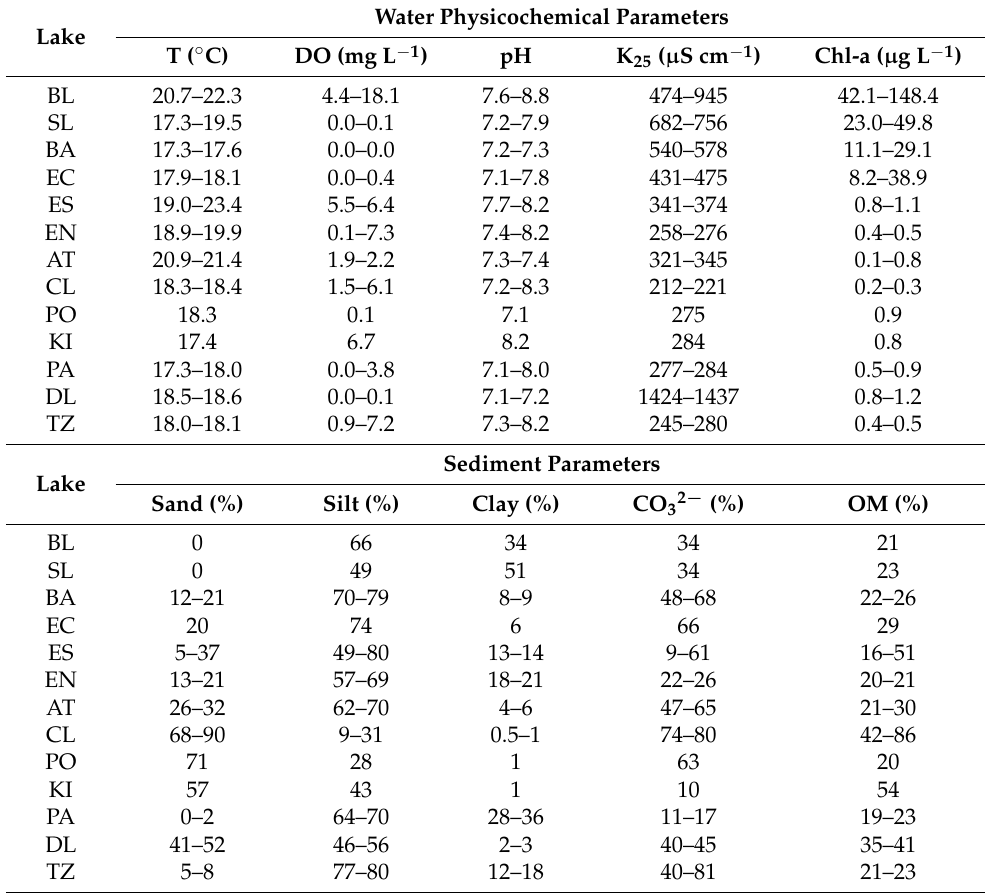
Table 2. Ranges of water physicochemical and sediment parameters of the Lakes of Montebello lakes: DO, dissolved oxygen concentration; K 25 , electric conductivity; T, temperature; Chl-a, chlorophyll-a concentration; CO 32 − , carbonates; OM, organic matter. Lakes’ abbreviations are as in Table